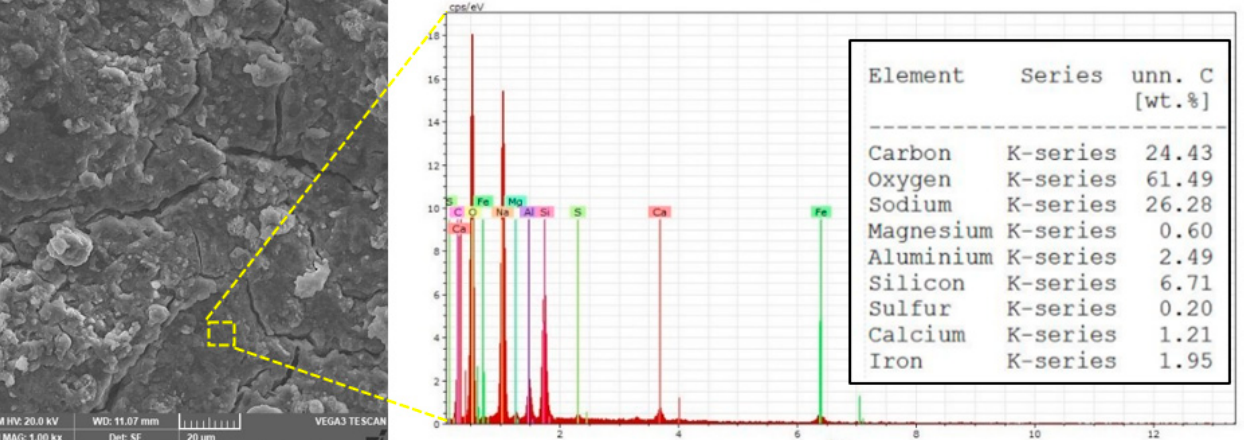
Figure 11. Schematic model of geopolymer bonding [45], with permission from Elsevier, 2021. 3.6. XRD Analysis The XRD patterns of fly ash-based geopolymers are shown in Figure 12. From this figure, it can be seen that the main crystal peak identified from the geopolymer paste is